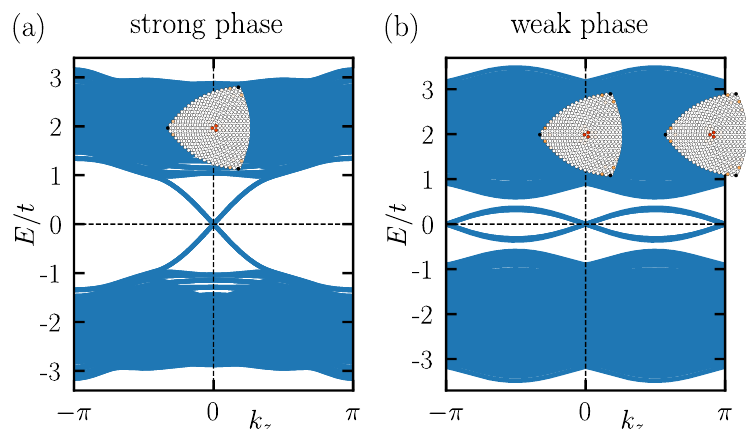
Figure 15: Bandstructures of 3D second-order topological superconductors in class DIII protected by fourfold symmetry: (a) strong topological phase and (b) weak topo- logical phase, with model Hamiltonians as defined in Eqs. (16) and (17), respectively. The corresponding models are realized in a pillar geometry with a line disclination parallel to the z axis. The insets show the real-space weights of the zero-energy states at the respective